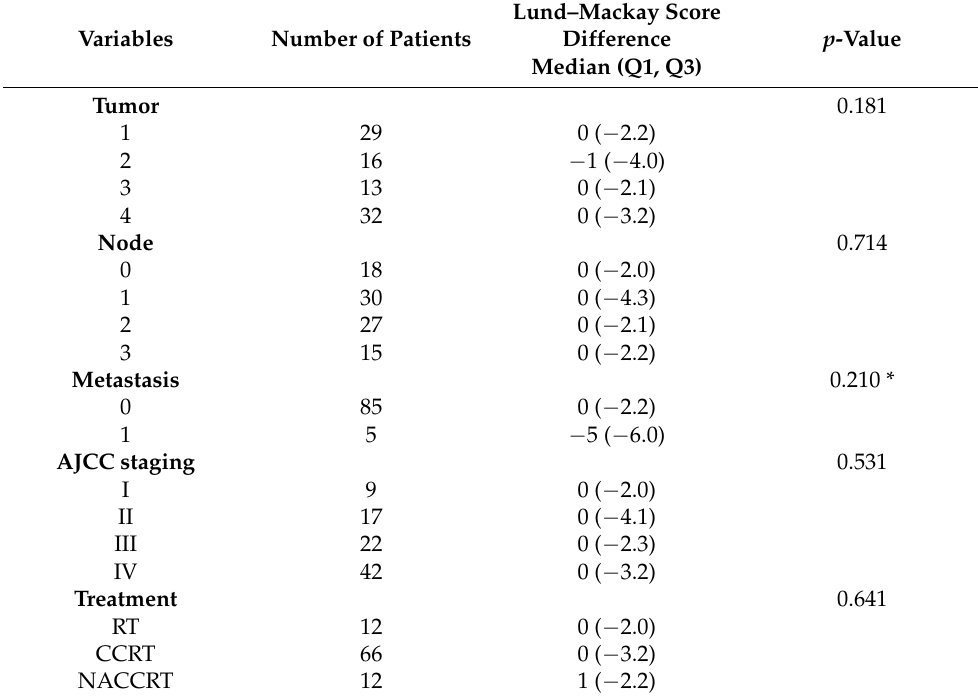
Table 3. The association between different variables and Lund–Mackay score difference.